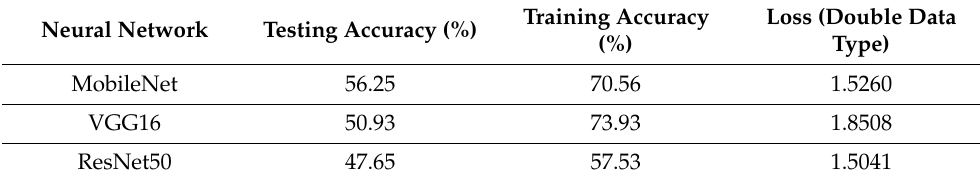
Table 5. Neural network accuracy and loss comparison.